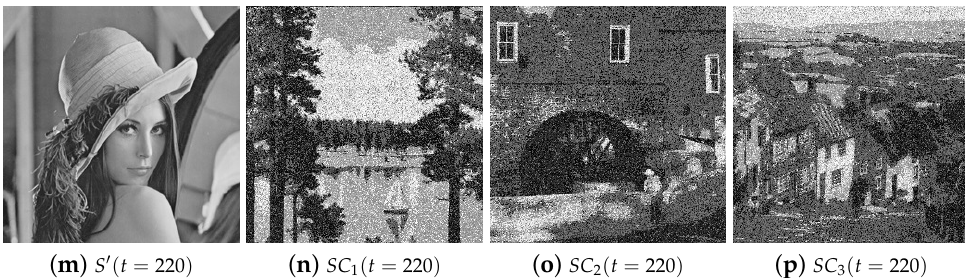
Figure 3. ( 2,3 ) threshold experimental results with t = 40, 130 and 220; ( a ) grayscale secret image; ( b – d ) three grayscale cover images; ( e – h ) three meaningful shadows and recovered secret image with t = 40; ( i – l ) three meaningful shadows and recovered secret image with t = 130; ( m – p ) three meaningful shadows and recovered secret image with t = 220.